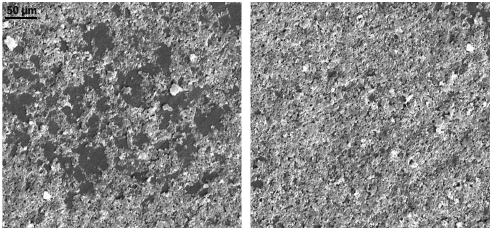
Figure A5. SEM image of polypropylene surface for non-ESD ( left ) and ESD ( right ) scaled to 50